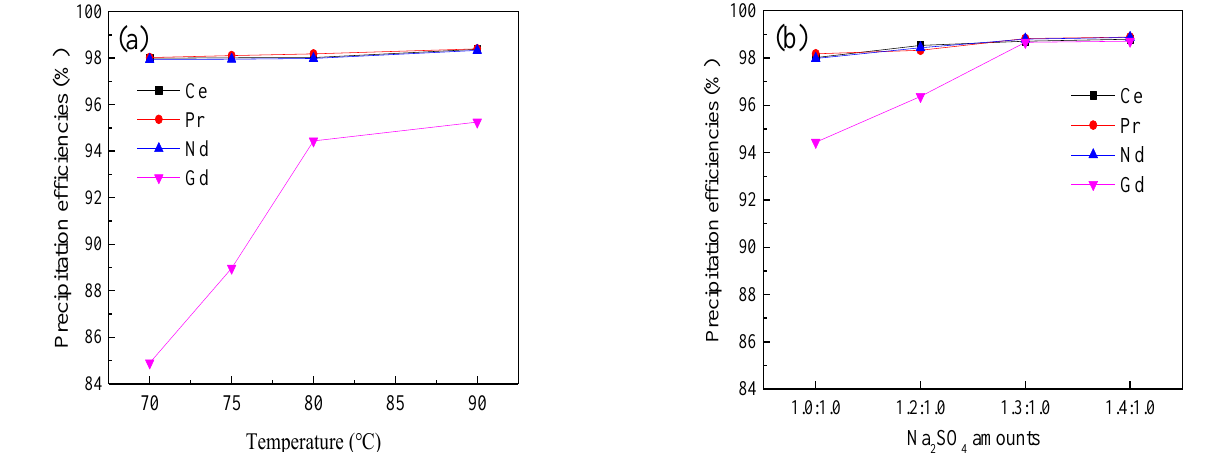
Figure 5. Effect of temperature ( a ) and Na 2 SO 4 amount ( b ) on the precipitation efficiencies of Ce, Pr, Nd, and Gd.